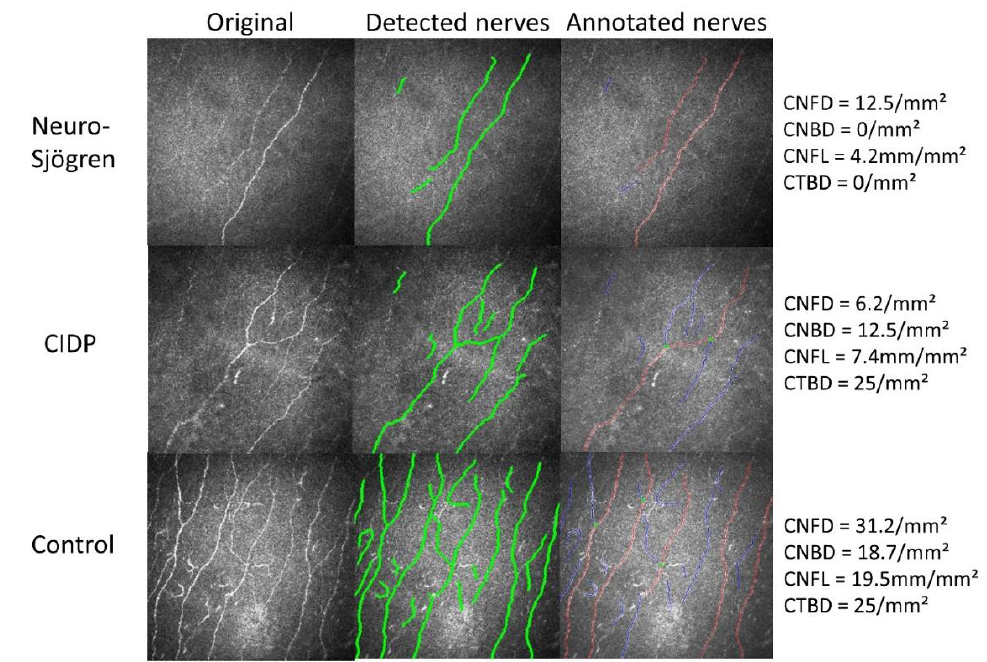
Figure 2. Exemplary findings in one patient with Neuro-Sjögren, one with CIDP and one participant of the control group. Image analysis is displayed for the automatically detected and colored nerves (green) and the annotated nerve fibres (red: main fibres, blue: nerve branches, green dots–branch points at the main fibres). Abbreviations; CIDP: chronic inflammatory demyelinating polyneuropathy; CNFD: corneal nerve fibre density; CNBD: corneal nerve fibre main branch density; CNFL: corneal nerve fibre length (total length of nerves); CTBD: corneal nerve fibre total branch density.